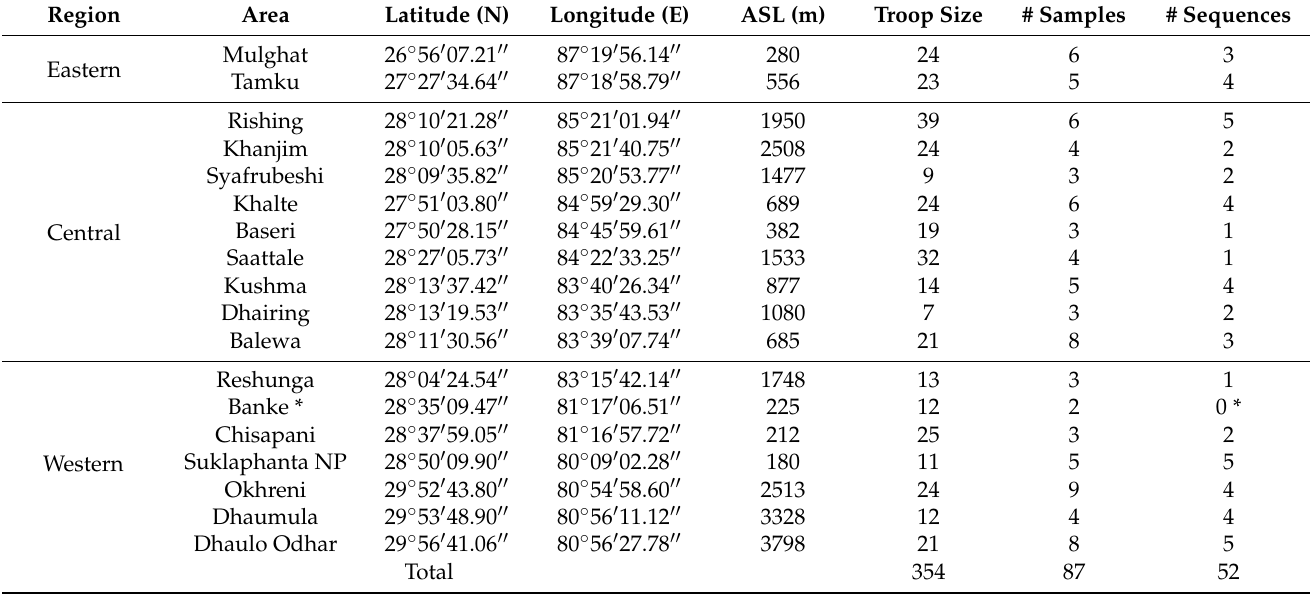
Table 1. Sampling sites of the Nepal Himalayan langurs, troop size and number of fecal samples